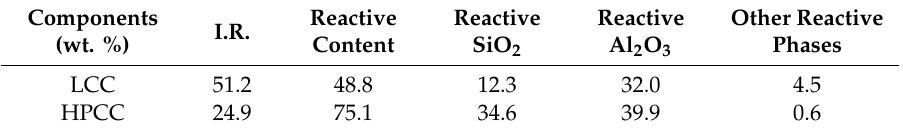
Table 2. Reactivity of low-grade calcined clay (LCC) and high-grade calcined clay (HPCC) (wt. %).